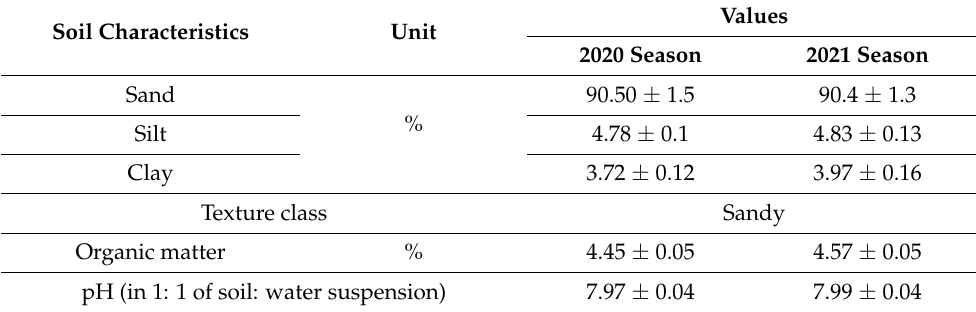
Table 1. Some major properties of the investigated